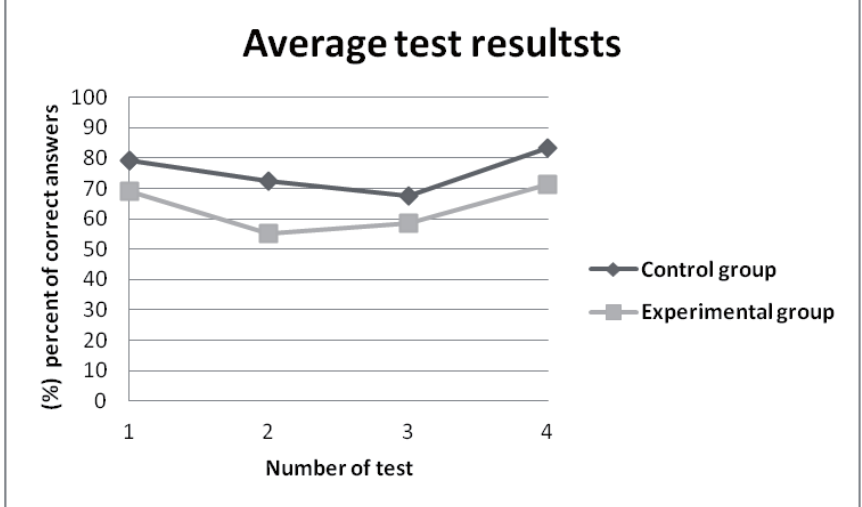
Fig. 1. Average test results of the experimental and the control group